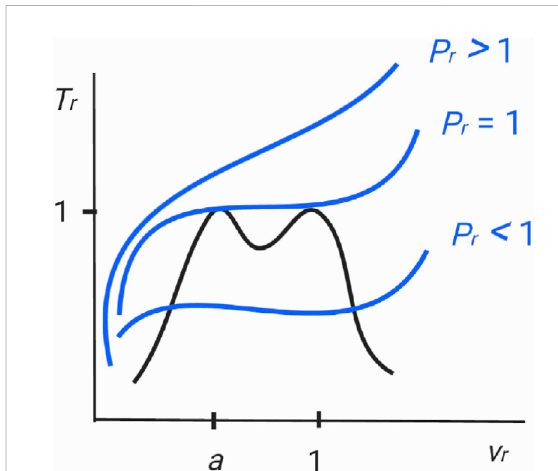
FIGURE 2 Diagram featuring the spinodal curve (red colored) and the critical isobar (blue colored) of the n = 4 Janus van der Waals equation with the two adjacent critical points at v r = a = 0.99 and v r =1.00.Wehaveset χ =3.4556asfornitrogen(N ϵ = 2 ).Since 6.0846 × 10 – 15 (17), the two critical isobars P r = 1 and P r = 1 + ϵ are indeed practically indistinguishable. The (common) critical